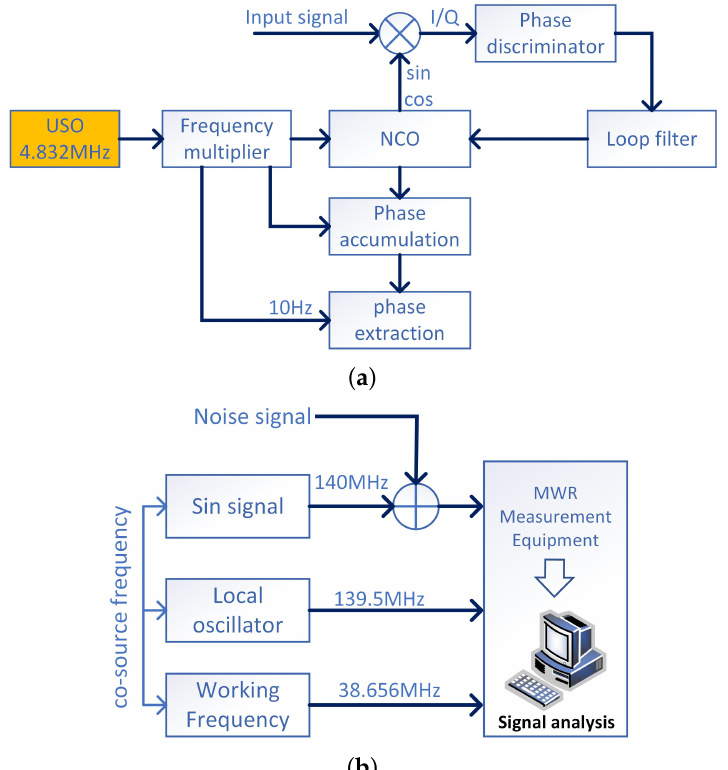
Figure 8. MWR ranging accuracy performance test. ( a ) digital phase locked loop and phase extraction. ( b ) one way ranging test of MWR